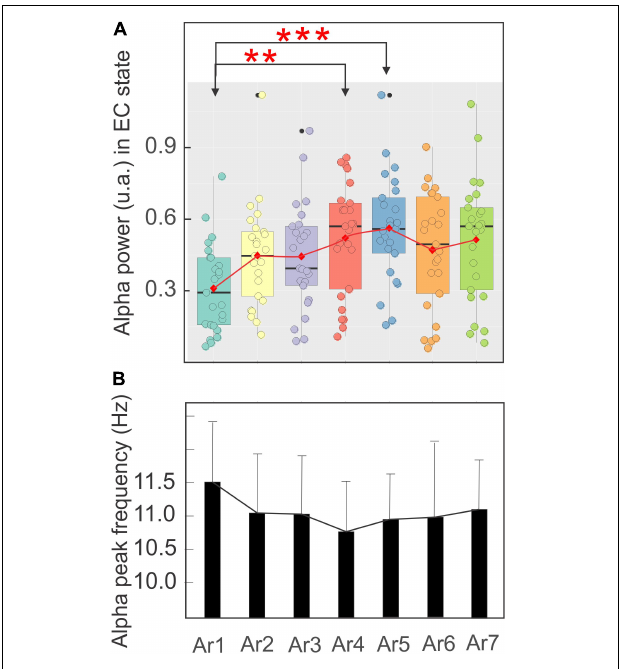
FIGURE 7 | Evolution of the mean ± SD of the power in a boxplot configuration (A) and of the frequency peak (B) of the alpha rhythm with the eyes closed from AR1 (control before the RB session) to AR7, in the five subjects who showed an increase of the alpha oscillation for at least one AR testing (AR2–AR7). The asterisk indicated the level of significance * p < 0.05 and ** p <